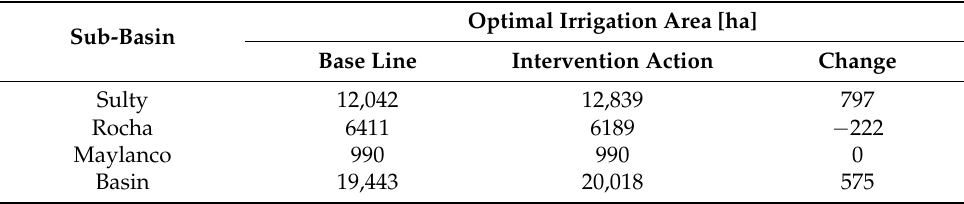
Table 7. Performance in irrigation of the intervention action of Siches